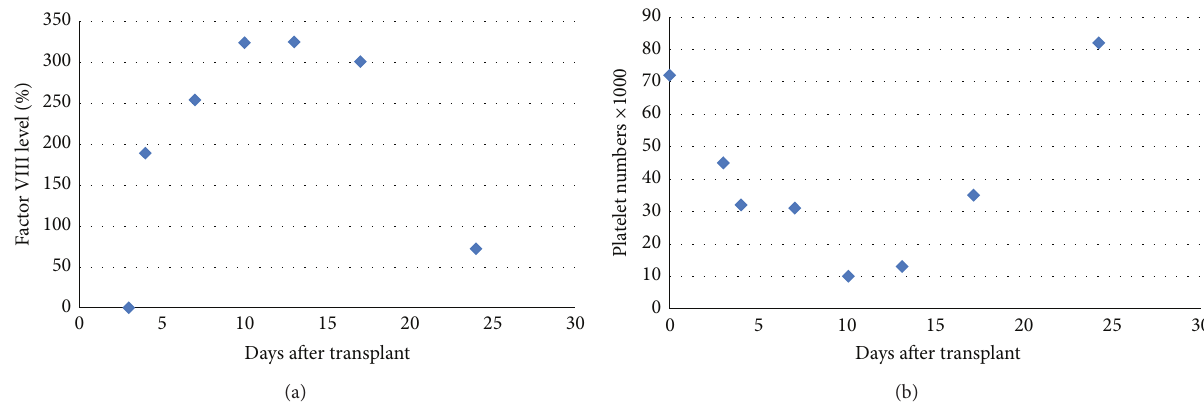
Figure 1: (a) Factor VIII level started to rise 4 days after transplant and slowly tapered off and stayed elevated up to 100 days after transplant. (b) Despite the fact that patient had severe thrombocytopenia by day +10 after transplant, no bleeding episodes were noted. (a) At the same time, the level of Factor VIII was the highest level which provided the protective role on bleeding prevention.